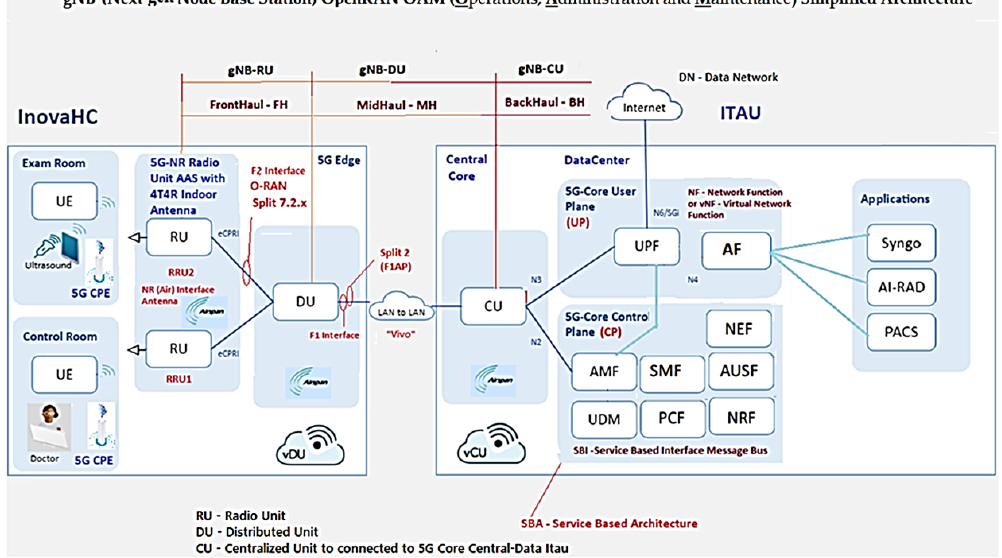
Figure 2. 5G xHaul network architecture of the Inovac OpenCare5G Project with simplified O-RAN OAM in the infrastructure layer. Based on